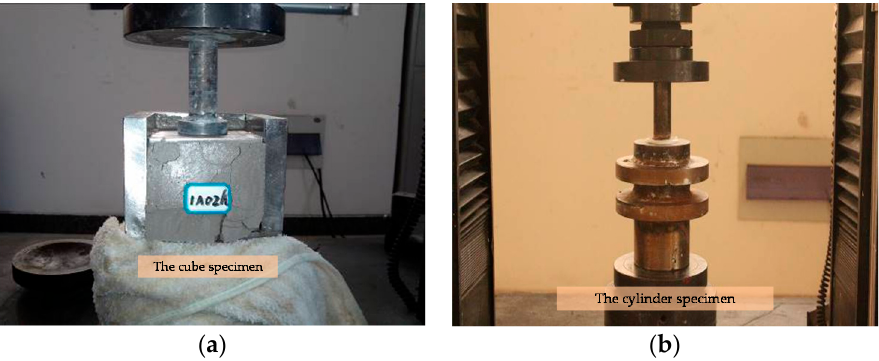
Figure 6. Confined compression test. ( a ) Partly confined compression test; ( b ) Completely confined compression test.